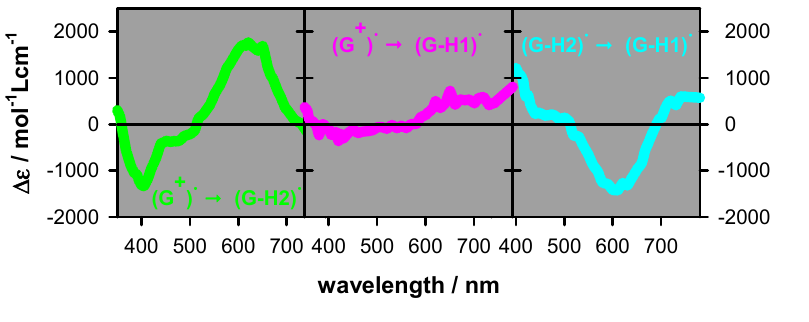
Figure 4. Difference spectra corresponding to ( G ) + • → ( G -H2) • , ( G ) + • → ( G -H1) • and ( G -H2) • → ( G -H1) • processes. They were determined from the spectra of monomeric guanosine radicals [23,24]. ∆ ε < 0 will be reflected by a decay in the transient absorption signal while ∆ ε > 0 by a rise.